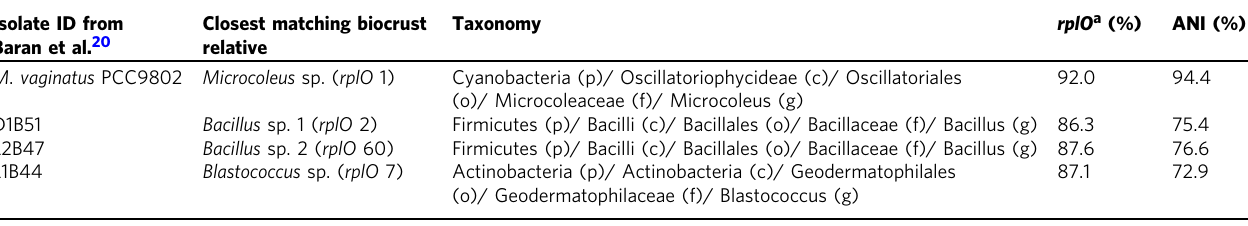
Table 1 Exometabolite-pro fi led isolates and their closest matching relative in biocrust Isolate ID from Baran et al.